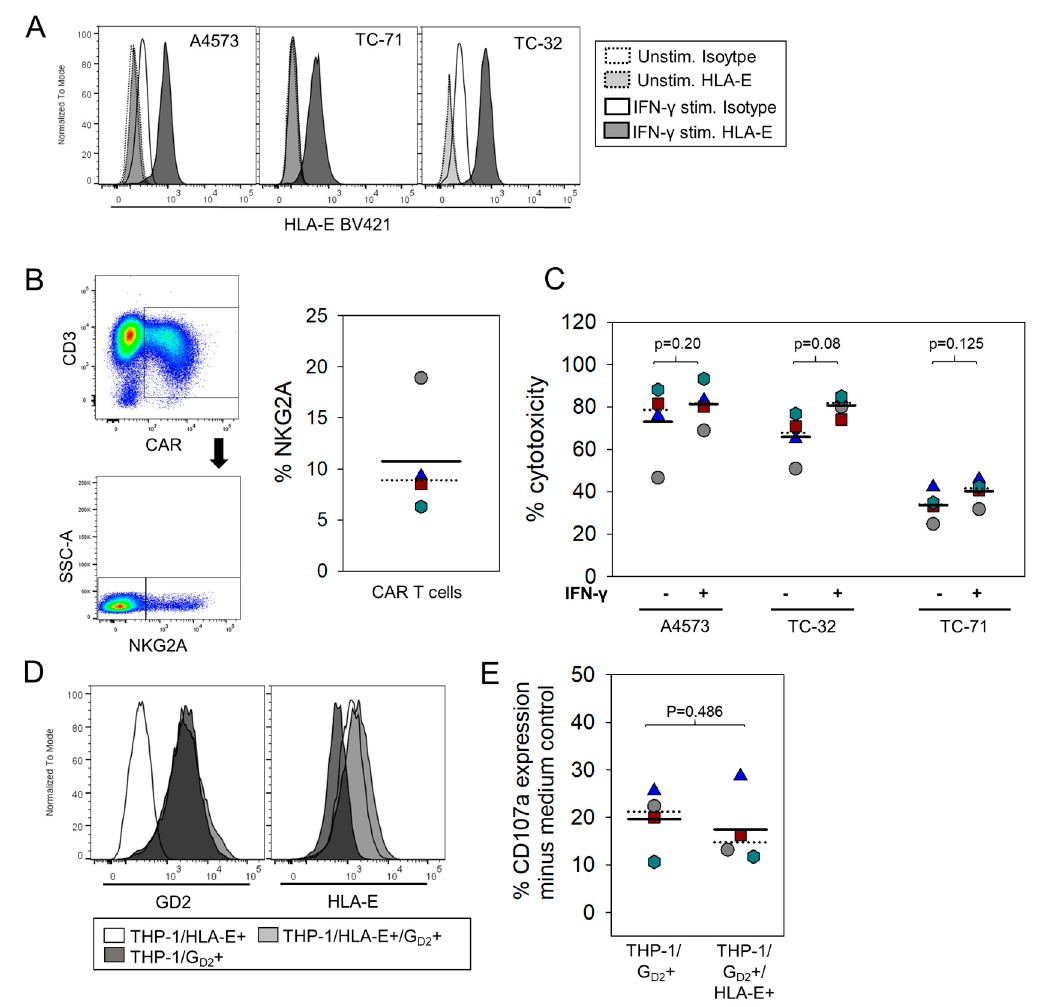
Figure 5. HLA-E expressed by THP-1 monocytic cells does not affect functional responses of CART. ( A ) Upregulation of HLA-E in EwS cells after incubation with IFN- γ . ( B ) NKG2A expression by flow cytometry in GD2-BB ζ CART generated from 4 donors. ( C ) Cytotoxicity assay of IFN- γ -induced, HLA-E-expressing EwS cells as targets for GD2-BB ζ -transduced effector T cells from 4 donors (effector-to-target ratio 40:1). ( D ) HLA-E and G D2 coexpression on THP-1 cells after retroviral gene transduction with HLA-E and GD3S/GD2S genes. ( E ) CD107a expression of GD2.BB ζ CART from 4 individual healthy donors after coincubation with HLA-E- and GD3S/GD2S-cotransduced THP-1 cells, and with HLA-E-negative, GD3S/GD2S-transduced THP-1 cells as controls. CD107a expression was analyzed after gating on CD3+ NKG2A+